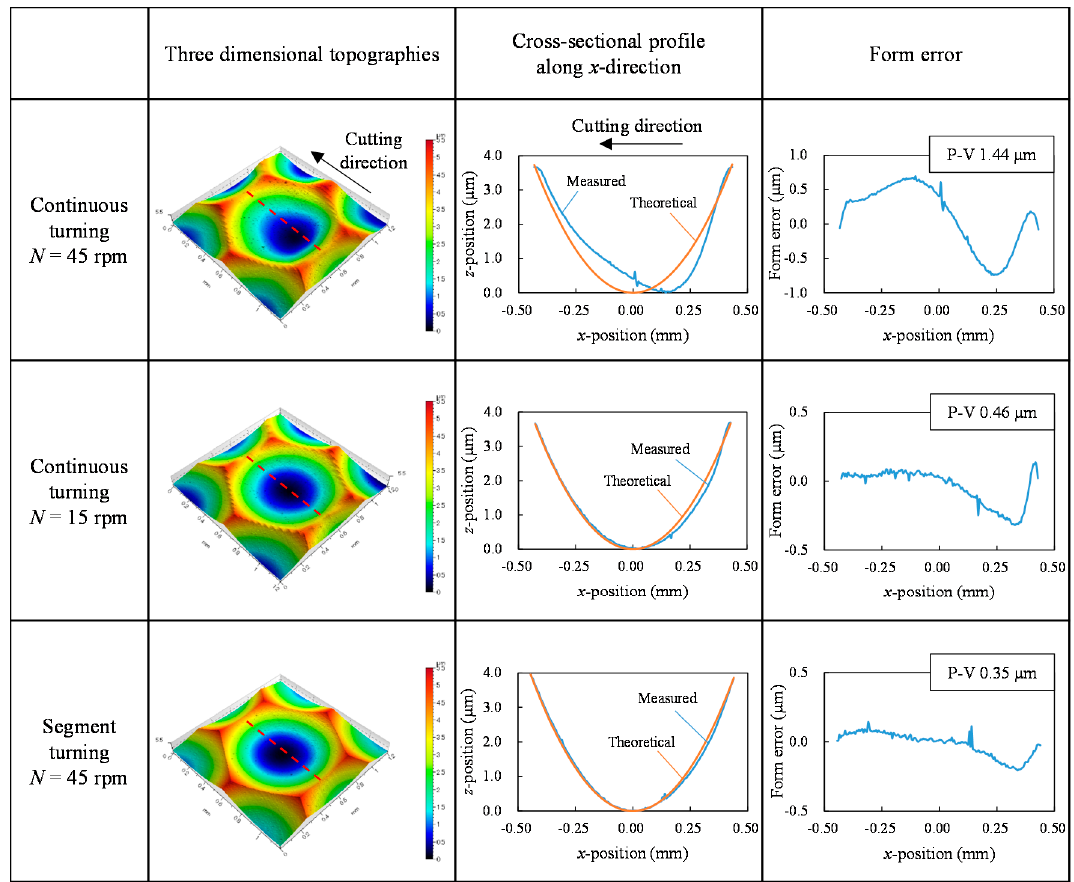
Figure 7. Three-dimensional topographies and cross-sectional profiles of lenslets the centers of which are located at x = 0 mm, y = 1.5 mm.